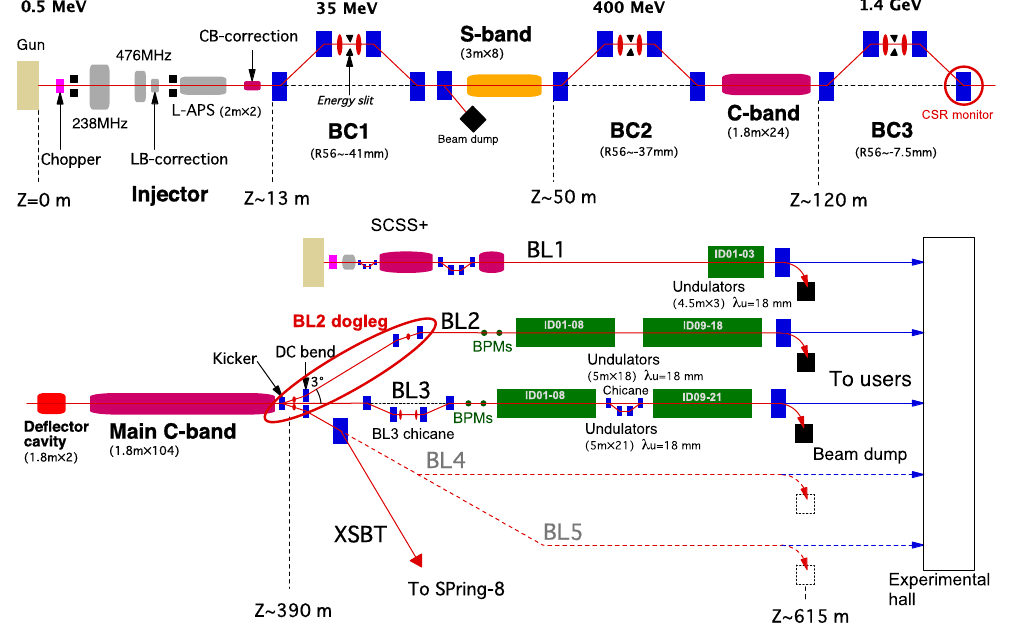
FIG. 1. Schematic layout of